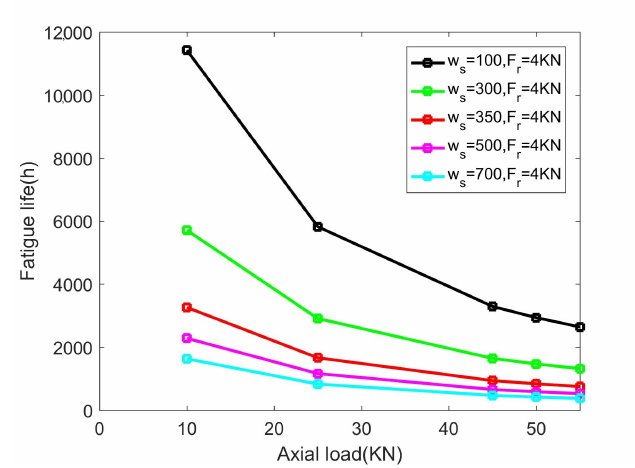
Figure 22. The fatigue life with different axial loads of case 2.